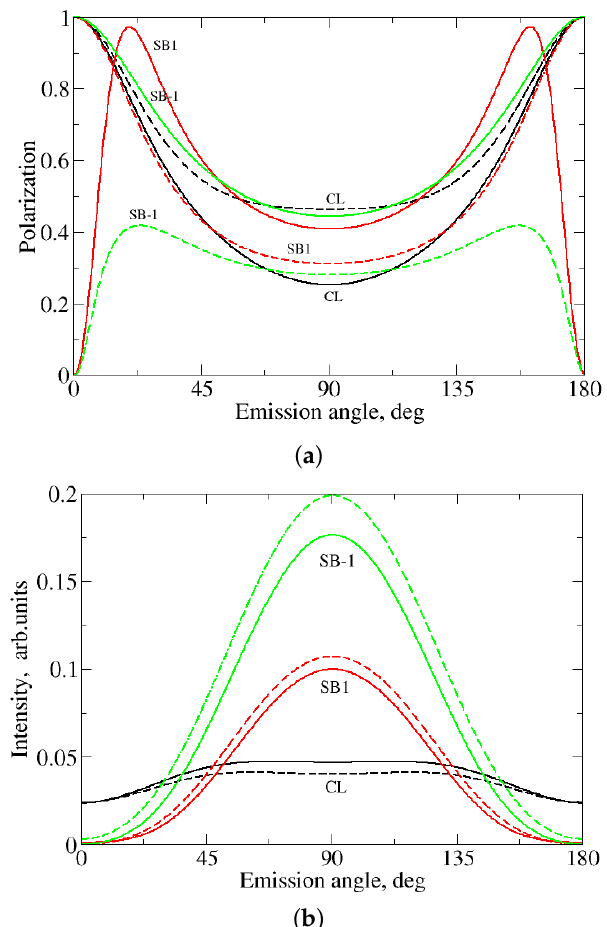
Figure 2. Angular distribution of the spin-polarization component P 1/2 z ( a ) and of the electron yield ( b ) for the XUV photon energy of 38.4 eV (the photoelectron energy without optical field is 25 eV) and the OP intensity 5.0 10 12 W/cm 2 . Solid lines correspond to the left-circularly polarized OP, × dashed lines, to the right-circularly polarized. CL denotes central line. SB1—high-energy sideband. SB-1—low-energy